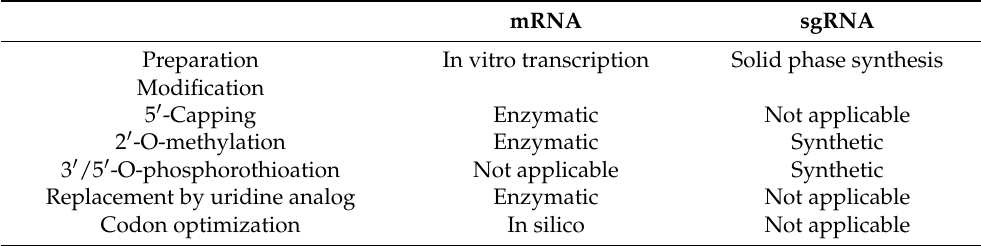
Table 2. Comparison of preparation and modification procedure for mRNA and sgRNA. mRNA sgRNA Preparation In vitro transcription Solid phase